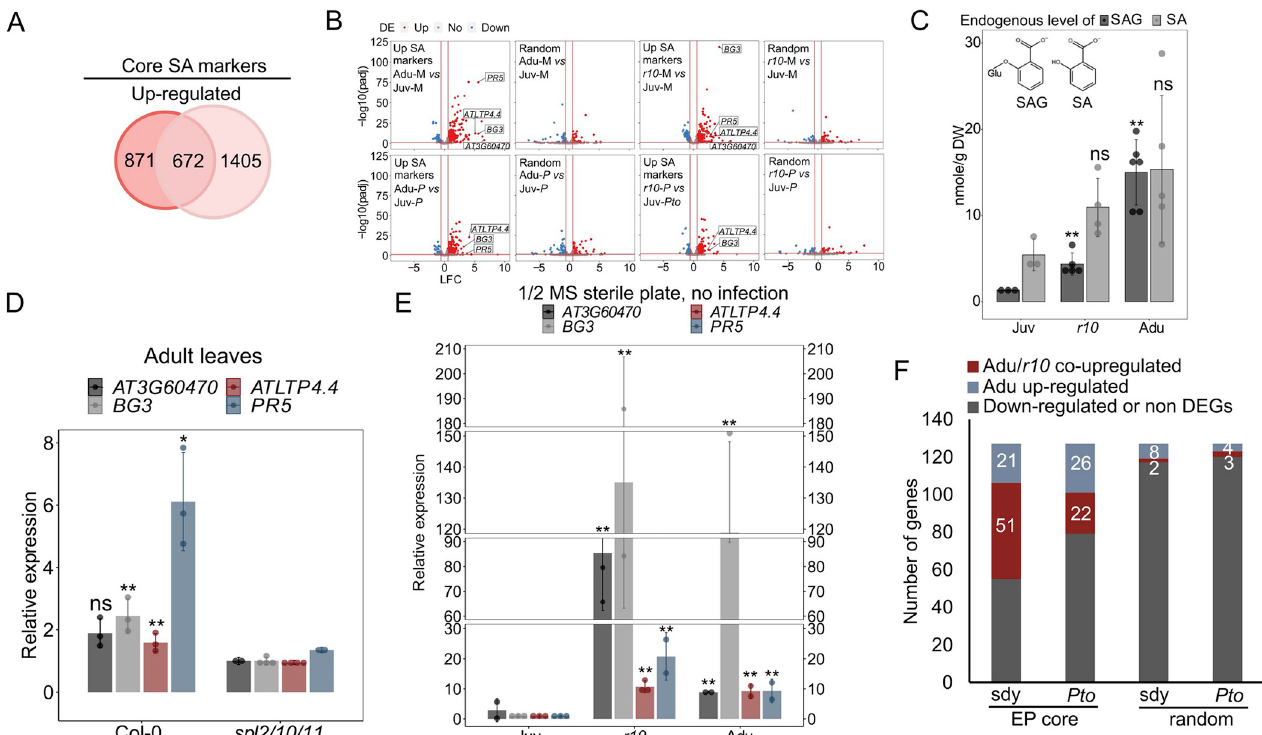
Fig 5. Salicylic acid (SA) biosynthesis and signaling were enhanced by SPL10 in adult phase. A , 672 up-regulated core SA markers were defined via overlapping DEGs pools from Ding Y et al ., 2018 (dark circle) [44] and Yang L et al ., 2017 (light circle) [43]. B , expression patterns of 527 detected (out of 672) up-regulated core SA markers in adult and r10 leaves, under non-infected and Pto infection states. Four random pools of detected genes (450 genes per set) derived from each pair-wise comparison exhibits here were chosen as negative controls. Up, upregulated. No, no change. Down, downregulated. Y axis shows the negative logarithm transformed adjusted p value, -log10(padj). X axis displays the value of Log2 fold change (LFC) of gene expressions. M, mock. P , Pto DC3000. P < 0.0001 (Hypergeometric test, done by GeneOverlap R package) was reproducibly output from each overlap between core upregulated SA markers , r10 nof and r10 (S1 Information). The P values for 3 out of 4 random controls were not significant (S1 Information). C , endogenous SAG and Adu nof , Adu pto pto and free SA accumulation in juvenile, r10 and adult leaves at non-infected state. DW, dry weight. Repeats for the experiment are shown in S2 Table. D , age- associated expression of four SA markers in adult leaves from Col-0 and in comparable leaves of spl2/10/11 . Similar results were seen two times. E , the qPCR of the four SA marker genes in juvenile, r10 and adult leaves on sterile 1/2 MS plates. Similar results were seen three times. F , overrepresentation of EDS1-PAD4 core regulon (EP core) in Adu/ r10 nof and Adu/ r10 . The EP core markers were defined in Cui et al ., 2017 [45]. 127/155 of the EP core markers were detected pto in this work. Randomly selected 127 genes from our RNA-seq dataset were used as controls.